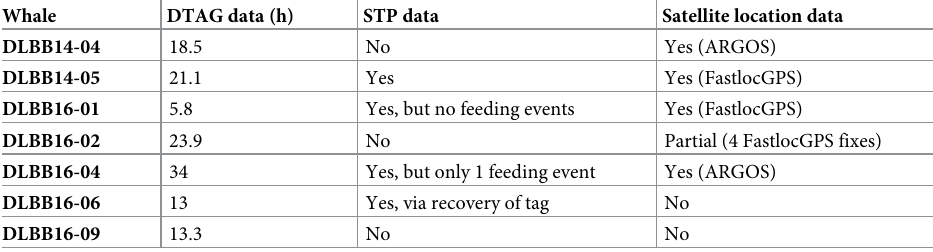
Table 1. DTAG data sets and availability of concurrent stomach temperature (STP) or satellite location data for belugas instrumented during the Bristol Bay beluga population heath assessment program in 2014 and 2016. Whale DTAG data (h) STP data